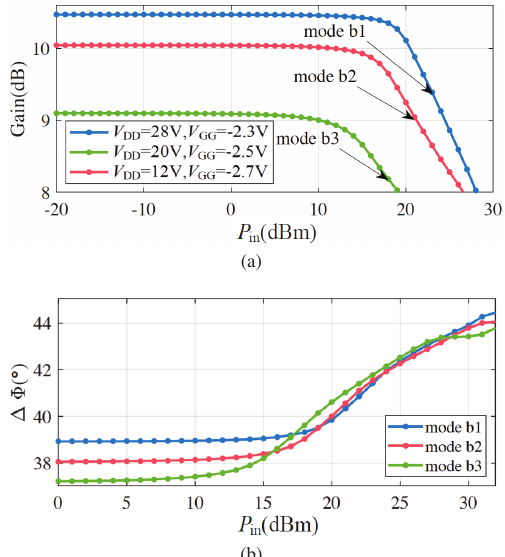
Figure 10. Nonlinear characteristics of Class A. ( a ) Gain curves versus input power for Class A. ( b ) AM/PM characteristic of Class A.